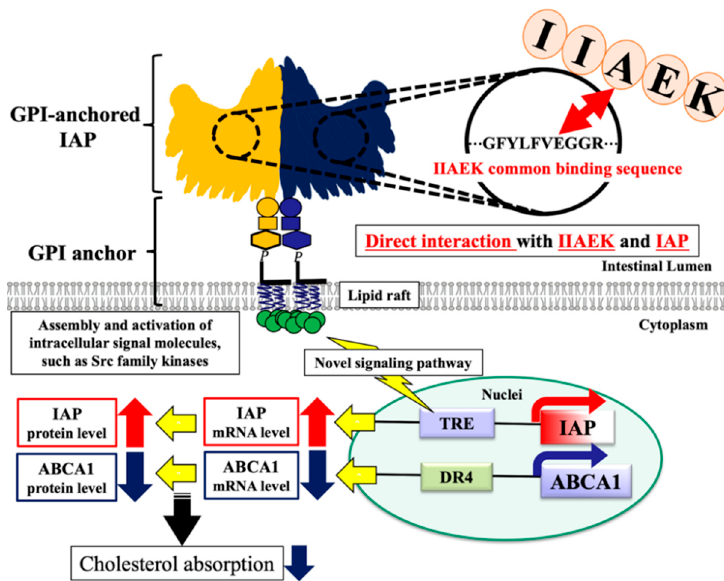
Figure 6. IIAEK–IAP interaction hypothesis. IIAEK interacts with IAP and improves cholesterol metabolism by the specific activation of IAP and downregulation of intestinal ABCA1.